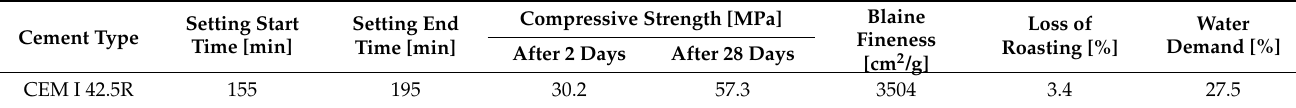
Table 2. Physical properties of cement.